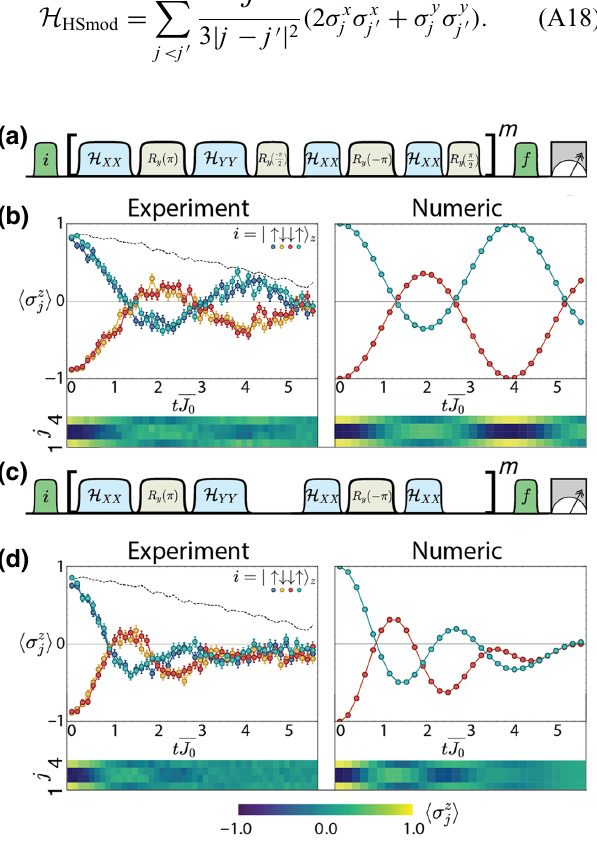
FIG. 8. Additional Haldane-Shastry data. (a),(b) The pulse sequence and data (left) compared to the numerics (right) for the approximate Haldane-Shastry experiment, using a different initial state than in Fig. 5 that shows especially simple recur- rences. (c),(d) The same as (a),(b) but with a modified pulse sequence that breaks the symmetries of the Haldane-Shastry sequence (see text). The dynamics no longer exhibit the sim- ple recurrences characteristic of near integrability and (cid:10) σ z (cid:8) is no longer conserved. The experimental points are the average of 200 repetitions, with error bars of 1 SEM.